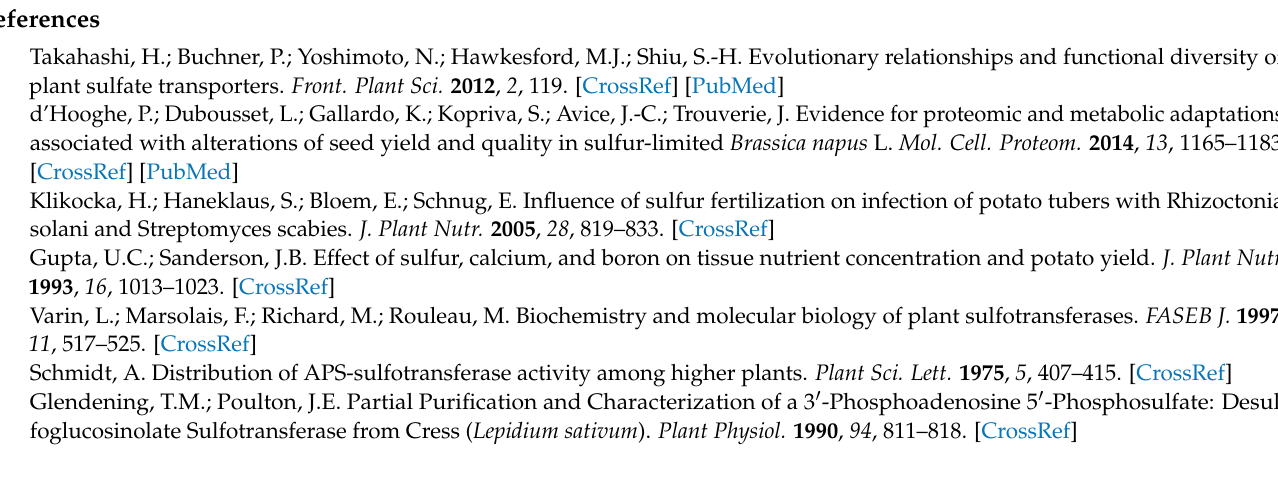
Table S1: The identified StSOT gene family members with Sulfotransferase domain (PF00685) from the Solanum tuberosum genome. The proteins post-transcriptional phosphorylation changes have been investigated. Table S2: The conserved motifs predicted in StSOT protein sequences. Table S3: The important cis-regulatory elements predicted in the promoter region of StSOT genes in potato. Table S4: The interaction relationships between Sulfotransferases and the other genes during multiple cellular functions. Table S5: The docking analysis of the Ligand binding site present in StSOT family proteins. The binding residues and metallic and non-metallic heterogenes were detected in blue spacefill, green spacefill, and colorful wireframe, respectively, in the related Figure